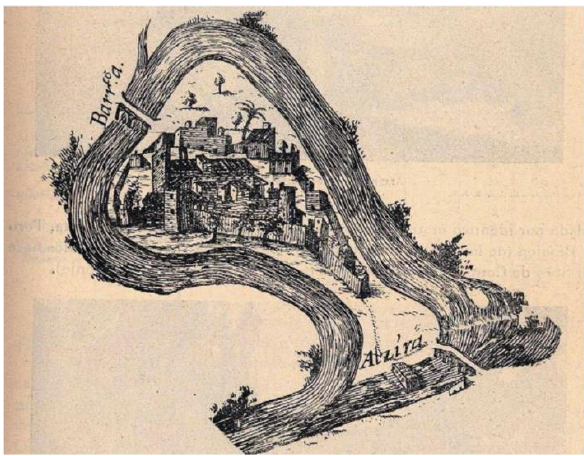
Figure 1. Historical representation of Alzira. (PEP – Alzira) The border of the historic town or "Vila" of Alzira, marked by its Moorish wall, represents the outline of its primitive settlement, in a particularly unique site that has always prompted the interest of its visitors. The Vila was divided into two well-defined